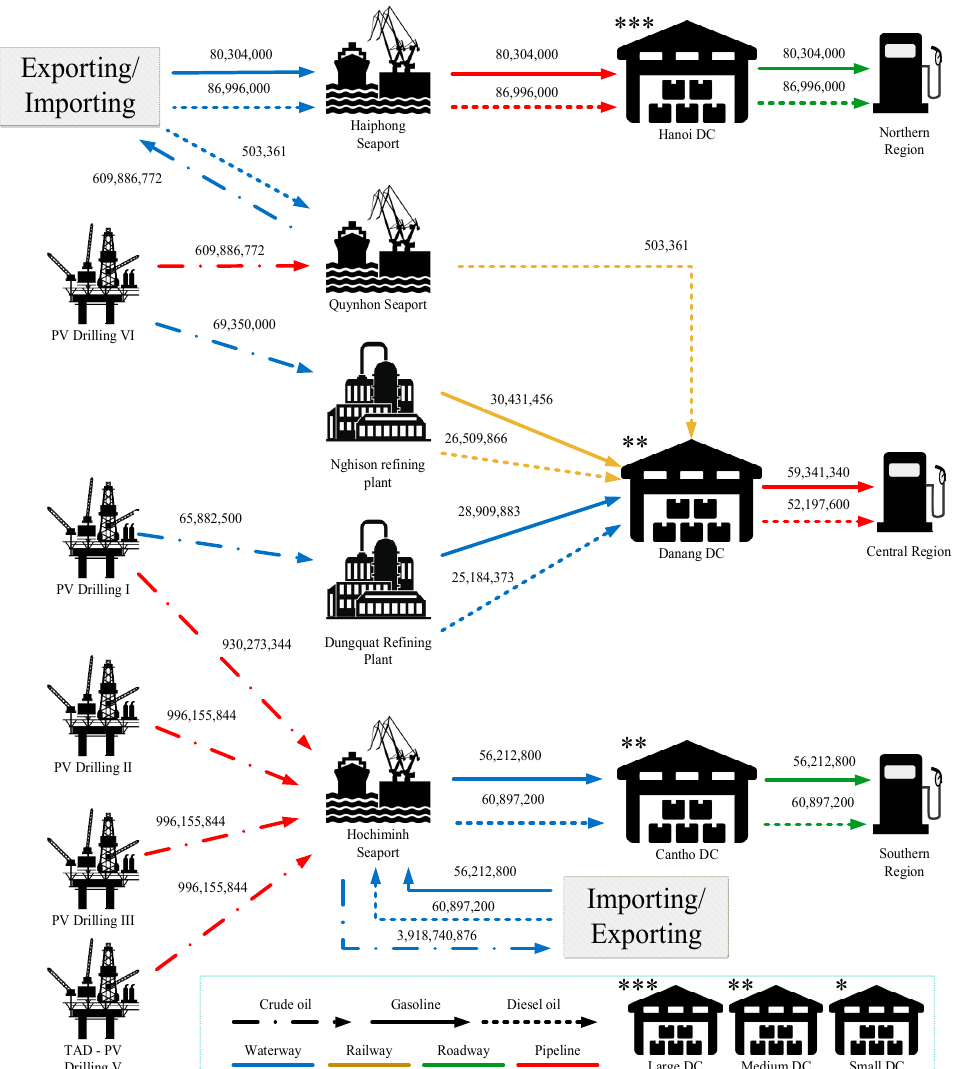
Figure 6. FMMGPM Vietnam Petroleum Supply Chain Configuration and Transportation Flow (in barrel).